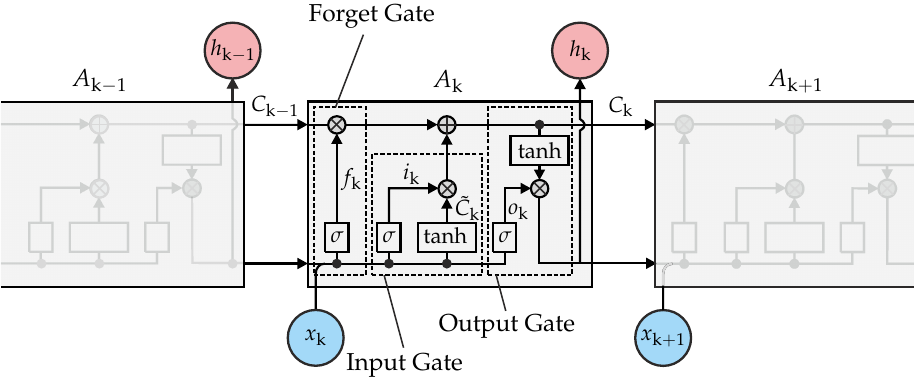
Figure 5. Block diagram of an LSTM network [23][24].